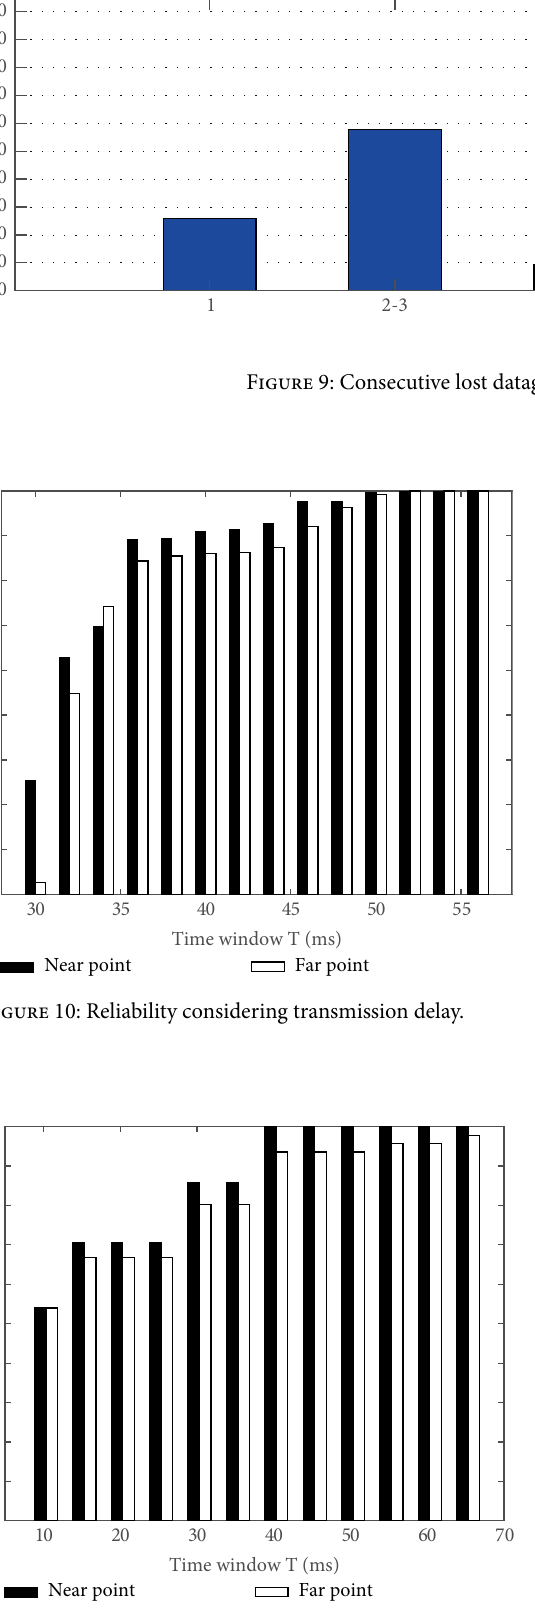
Figure 11: Reliability considering packet loss.